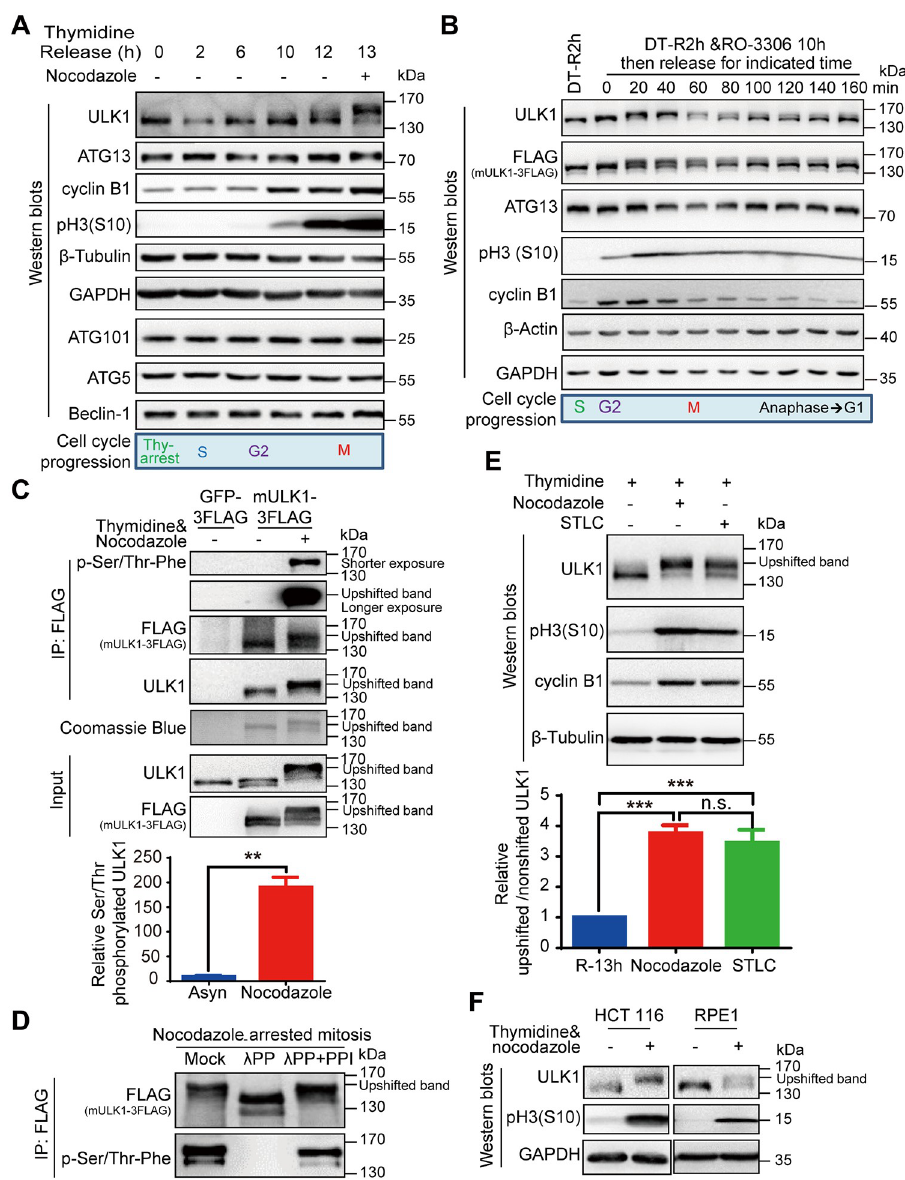
Fig 1. ULK1 undergoes electrophoretic mobility shift and is highly phosphorylated in mitosis. (A) ULK1-ATG13 shows a mobility shift in mitosis. HeLa cells synchronized by double-thymidine release in the presence or absence of nocodazole were subjected to SDS-PAGE and western blot analysis. (B) ULK1-ATG13 undergoes band shift during mitotic progression. HeLa cells synchronized by double-thymidine and RO-3306 were released into mitosis for western blot analysis. (C) ULK1 is phosphorylated in nocodazole-arrested mitosis. The 293T cells overexpressing FLAG-tagged mULK1 or GFP were synchronized by single-thymidine and nocodazole. The immunoprecipitates using the FLAG antibody were subjected to Coomassie Brilliant Blue R-250 staining and western blot analysis. Statistical analysis for relative serine/threonine phosphorylated ULK1 was shown in Fig 1C, lower panel. n = 4, �� p < 0.01. (D) The immunoprecipitates from Fig 1C were treated with or without λ PP in the presence or absence of PPIs and then subjected to western blot analysis. (E) ULK1 undergoes mobility shift in both nocodazole- and STLC-arrested mitosis. HeLa cells synchronized with single-thymidine and nocodazole or STLC were analyzed by western blot analysis. The upper panel shows the immunoblotting and the lower panel shows the ratio of upshifted and nonshifted ULK1. One- way ANOVA followed by Tukey’s multiple comparison test was used for the analysis. n = 5, ��� p < 0.001. (F) ULK1 undergoes phosphorylation-induced electrophoretic mobility shift in single-thymidine and nocodazole synchronized mitotic HCT 116 and RPE1 cells analyzed by western blot analysis. Numerical data underlying the figure panels are available in S1 Data. Asyn, asynchronous; ATG, autophagy-related; DT-R2h, double-thymidine block and release for 2 hours; GAPDH, glyceraldehyde 3-phosphate dehydrogenase; GFP, green fluorescent protein; IP,